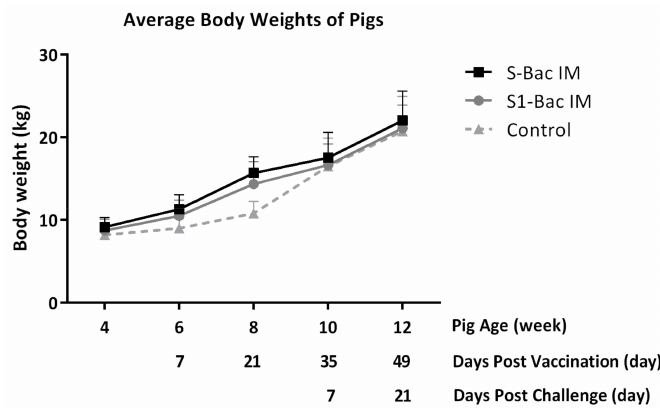
Figure 9. The average body weight of piglets in each group. The body weight of the piglets was measured in two-week intervals since the piglets were 4 weeks old. The X axis is the time line, indicating the age of the piglets, days post vaccination, and days post challenge. The piglets were vaccinated twice at 5 weeks old and 7 weeks old (labeled with white arrows); the piglets were challenged with 5 × 10 5 TCID50 PEDVPT-P6&7 at 9 weeks old (labeled with a black solid arrow). The Y axis is the averaged body weights of five piglets in each group. The error bars represent the SD values of each group in different time points. The solid line with square icons and the gray line with round icons represent the average body weights of pigs in the S-Bac group and S1-Bac group, respectively. The average body weight of pigs in the control group is expressed as the dotted line with triangle